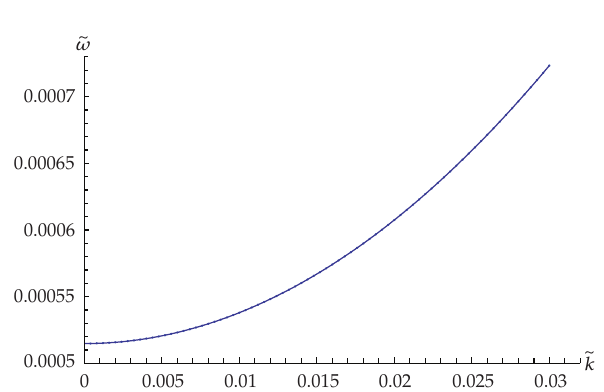
Figure 11: Plot of the dispersion relation of the pseudo-Goldstone mode for (cid:5) m ≈ 0 . 0007. The parabolic fit corresponds to (cid:3) 4.128 (cid:4)